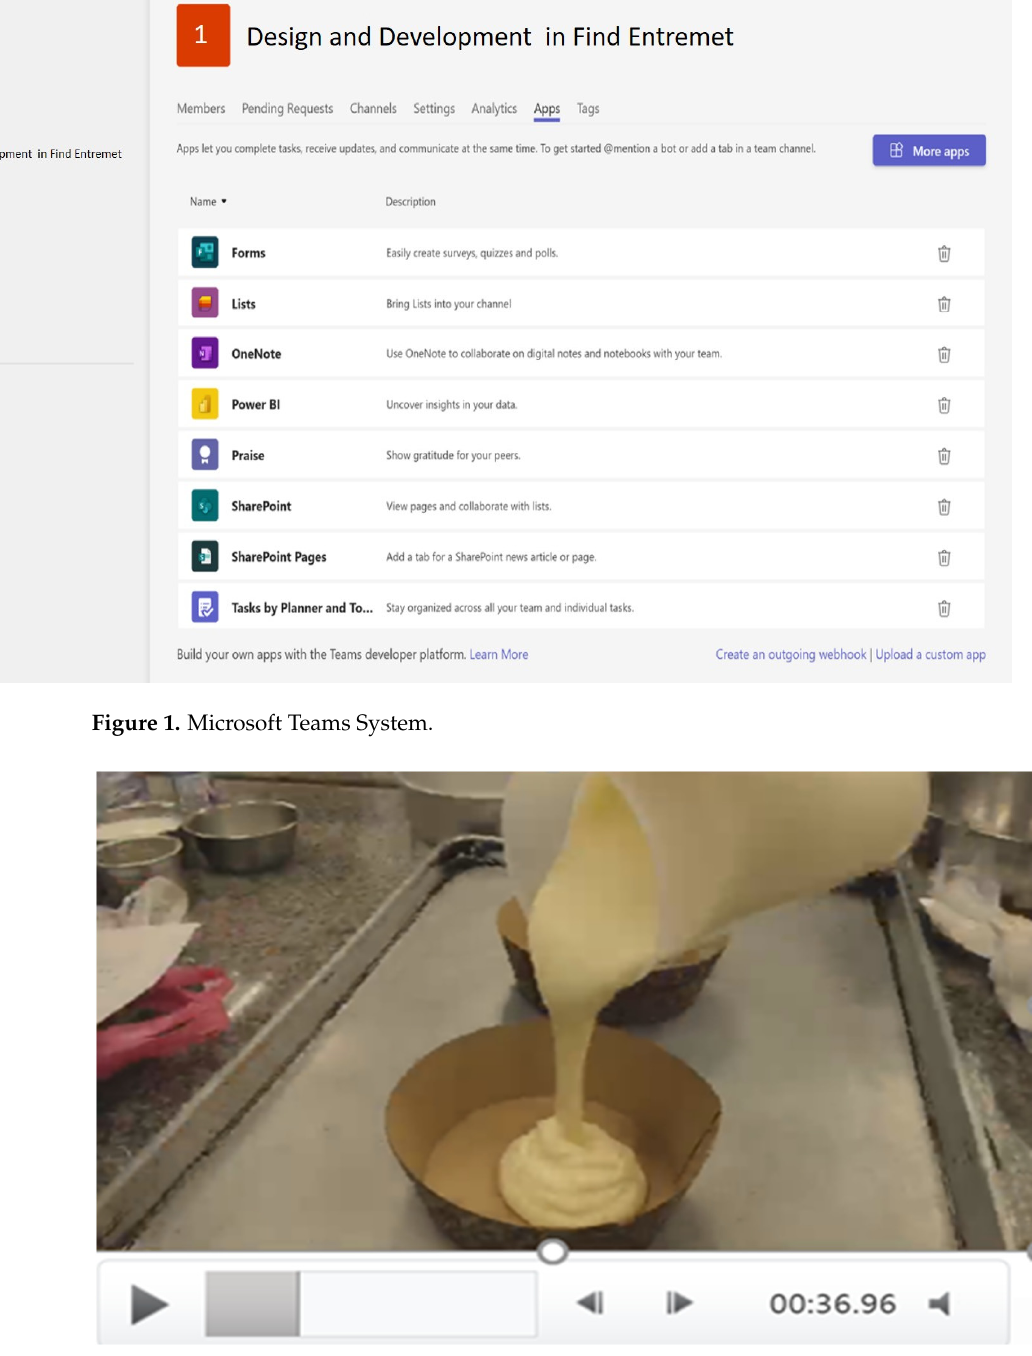
Figure 2. Videos for making dessert